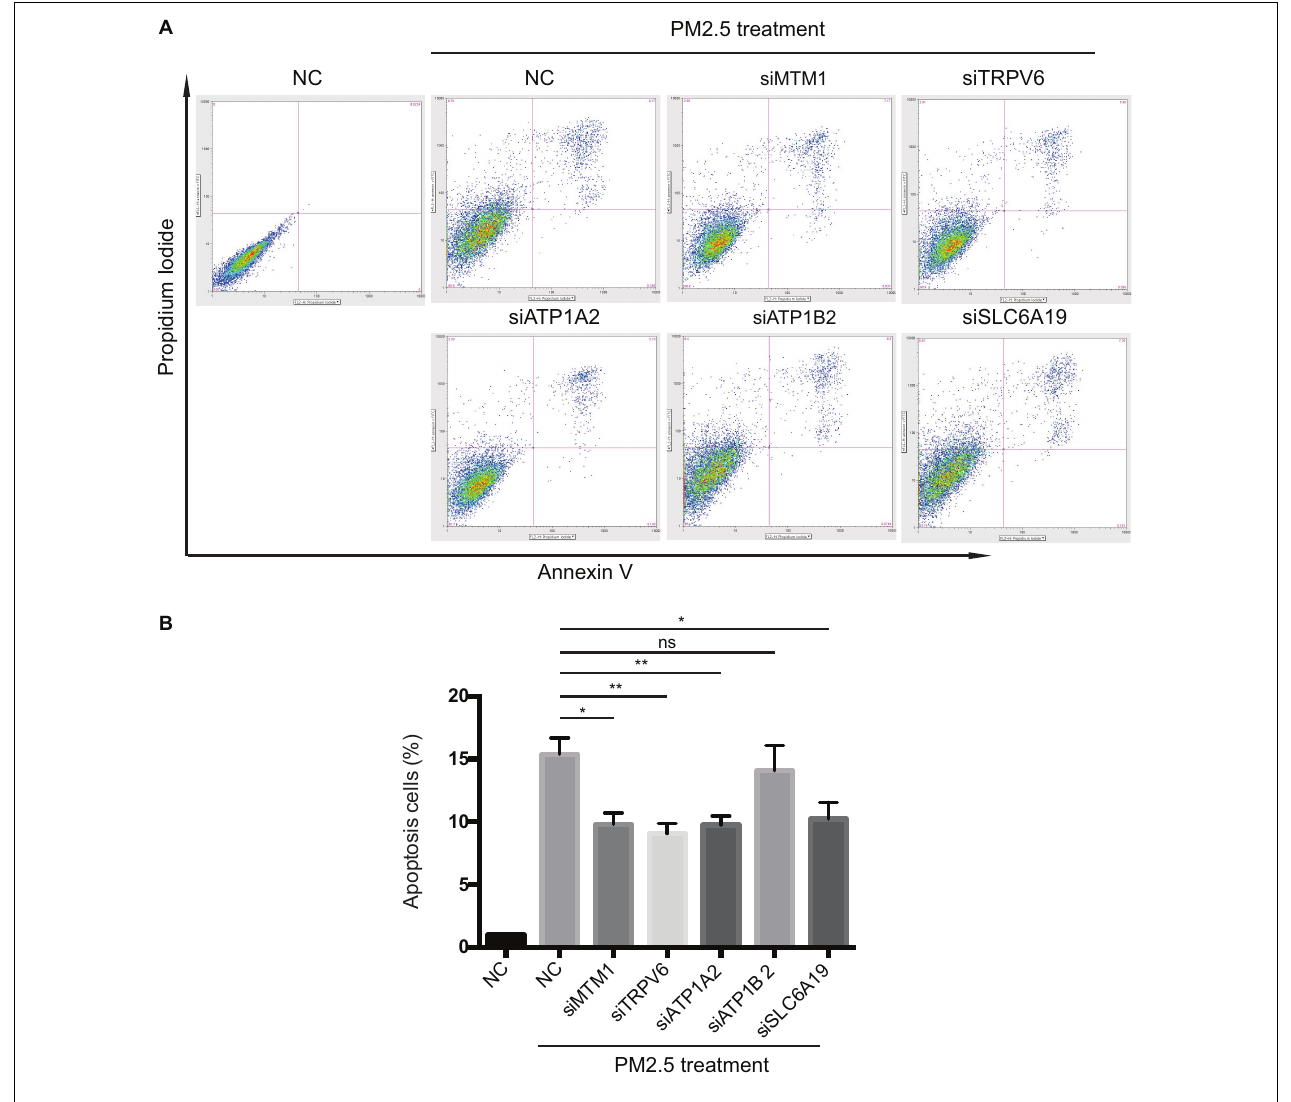
FIGURE 4 | Knocking out of genes associated with mineral absorption suppressed PM 2 . 5 -induced apoptosis. (A) Cells were treated with PM 2 . 5 , while apoptosis was detected via Annexin V + PI staining. NC, Negative control. (B) Analysis of relative levels of cell apoptosis. * p < 0.05, ** p < 0.01. ns, no significance. Data are representative of three independent experiments with n = 3 (Mean ± SEM), normalized by NC